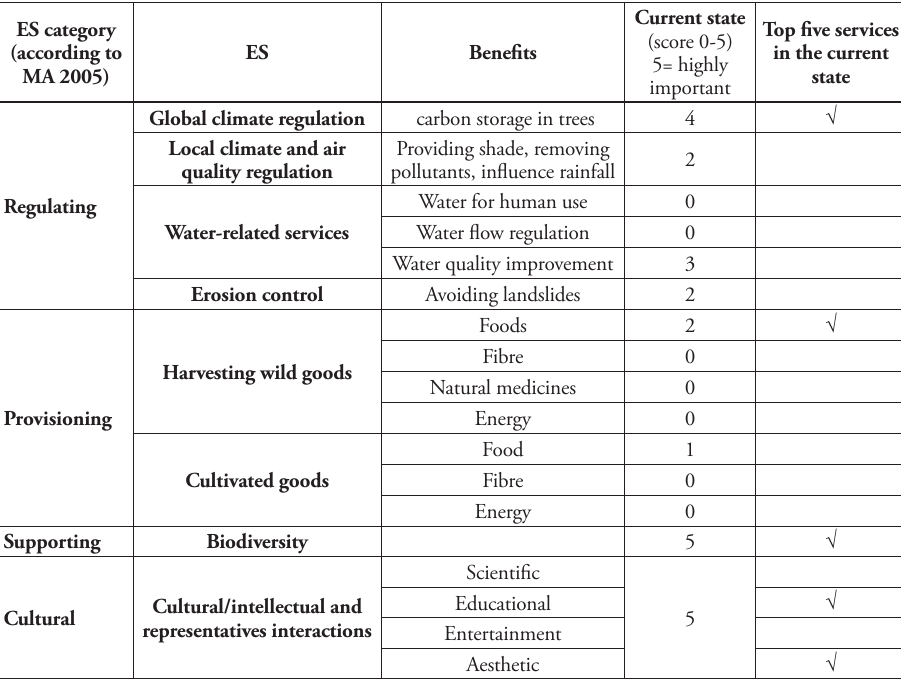
Table 2. Potential ecosystem services at the current state of the